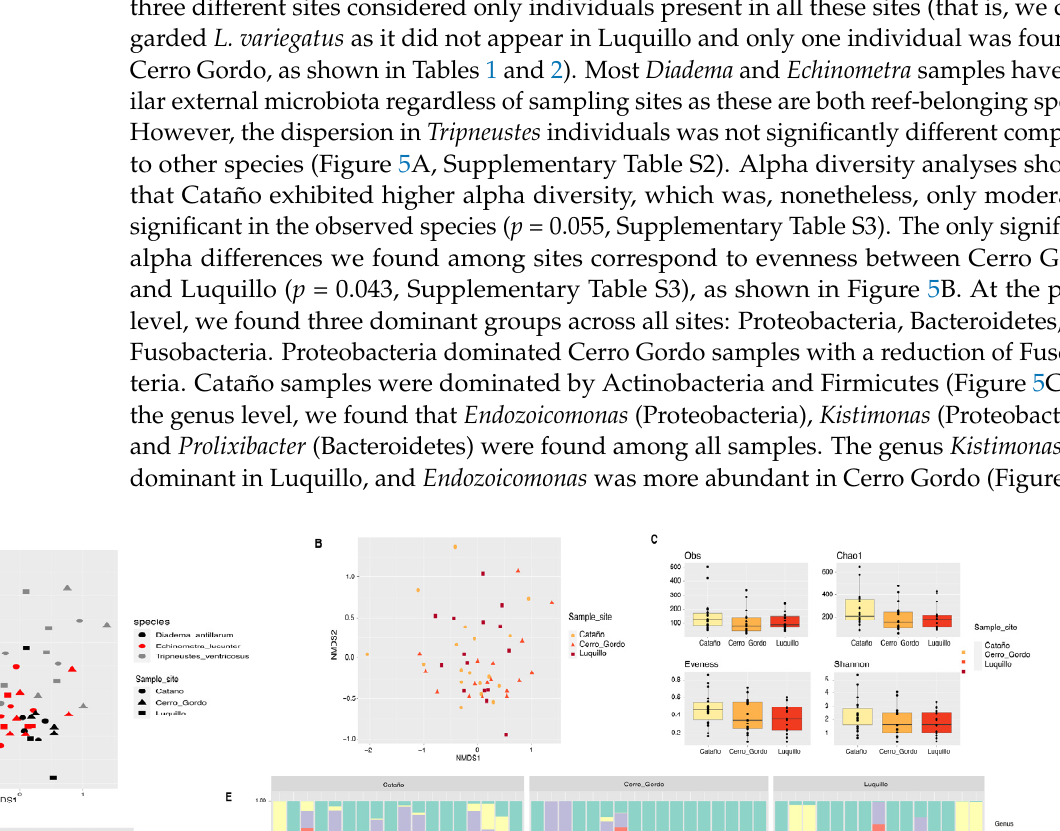
Figure 4. Differences in relative abundances of genus-level taxa between ( A ) sea urchin species and ( B ) trophic niches (reef vs. seagrass) by LEfSe analysis (Logarithmic LDA score > 2.0; alpha value < 0.05).